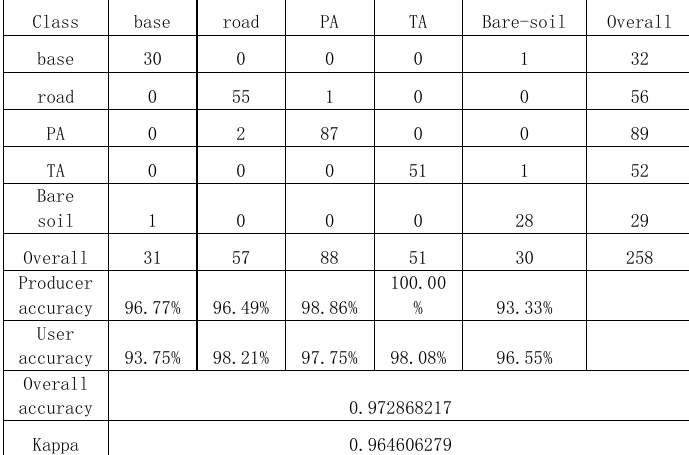
Table3. Multi-scale object-oriented extraction accuracy